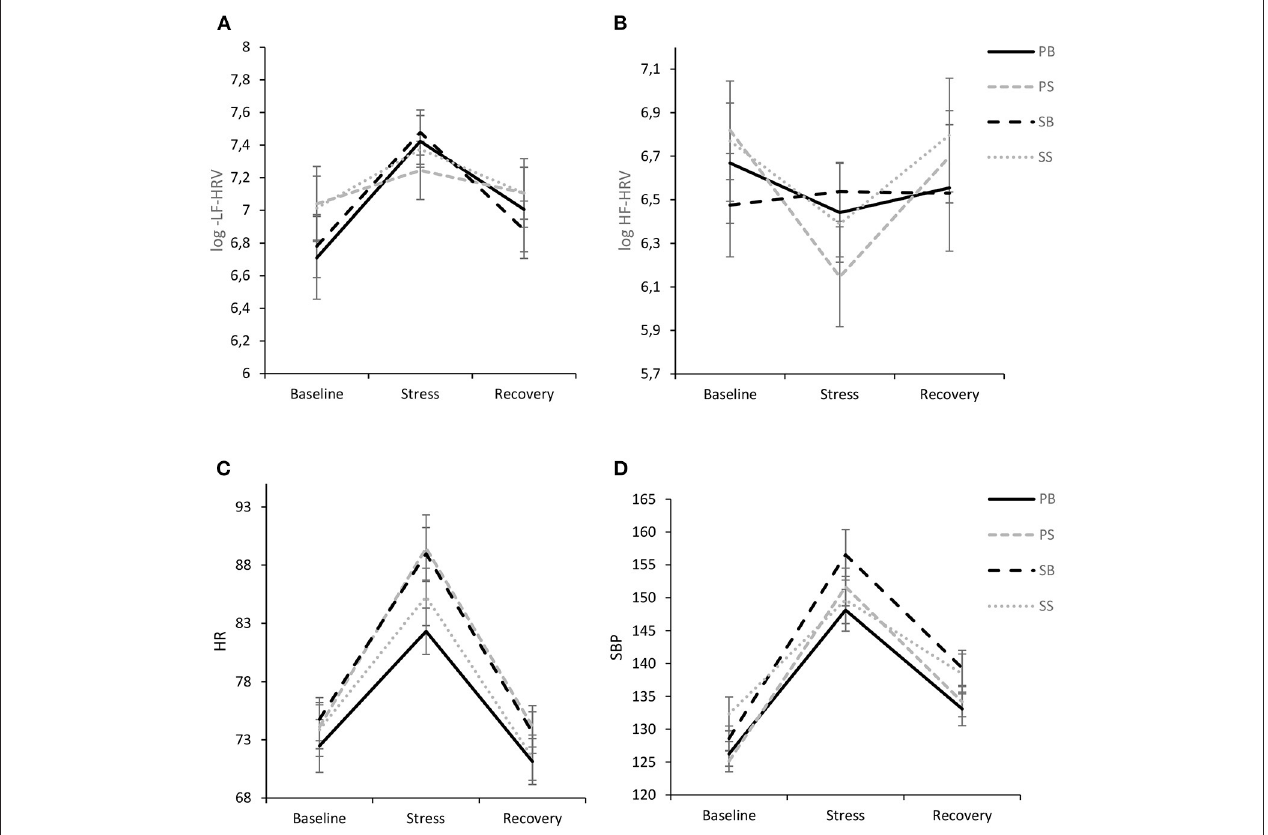
FIGURE 4 | Interaction of experimental intervention and time (M ± 1 SE) for log LF-HRV (A) , log HF-HRV (B) , HR (C) , and SBP (D) . PB, paced breathing at 0.1Hz; PS, paced singing at 0.1Hz; SB, spontaneous breathing; SS, spontaneous singing. This figure show pronounced cardiovascular stress reactivity, but no differences between interventions.